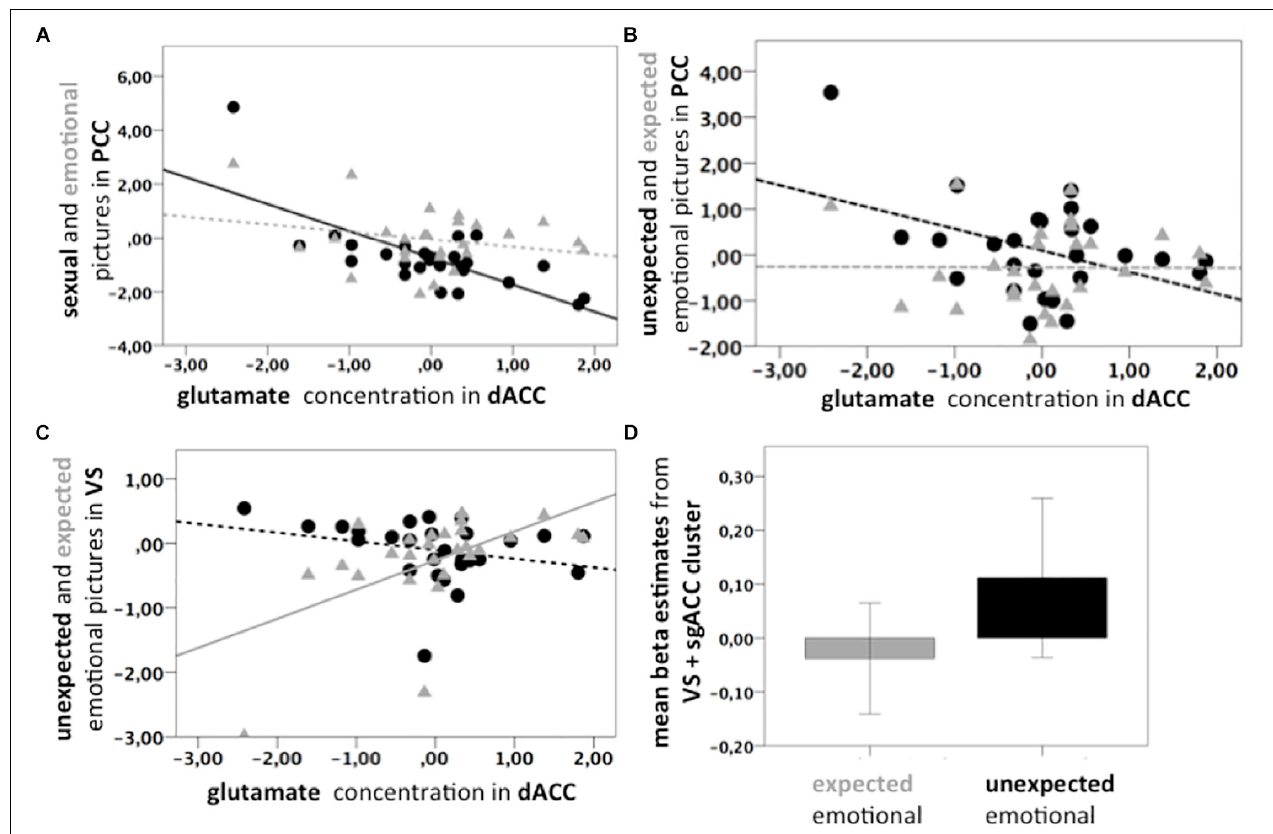
FIGURE 3 | (A) Scatter plots. Black line: Significant negative correlation of the Glu/tCr residuals in dACC and PCC BOLD response for Psex > fix ( p = 0.003, ρ = –0.556, n = 27); Gray dotted line: Non-significant correlation of Glu/tCr residuals and PCC BOLD response for Pemo > fix ( p = 0.217, ρ = 0.313, n = 27). Slopes are significantly different ( p < 0.001). Beta estimates were extracted from the correlation cluster (light blue and yellow) shown in Figure 2A . (B) Black dotted line: Non-significant negative correlation of Glu/tCr residuals in the dACC and PCC BOLD response uPemo > fix ( p = 0.462, ρ = –0.148, n = 27). Gray dotted line: Non-significant correlation of Glu/tCr residuals in the dACC and PCC BOLD response for xPemo > fix ( p = 0.980, ρ = 0.183, n = 27). Beta estimates were extracted from the correlation cluster (light green and bright green) shown in Figure 2C . (C) Gray line: Positive correlation between xPemo > fix and Glu/tCr residuals in dACC ( p = 0.004, ρ = 0.539, n = 27). Black dotted line: Non-significant negative correlation between uPemo > fix and Glu/tCr residuals in dACC ( p = 0.075, ρ = –0.348, n = 27). Beta estimates were extracted from the bright green correlation cluster shown in Figure 2D . (D) Mean beta estimates for xPemo > fix and uPemo > fix represent a relative signal increase for the unexpected condition. Data is presented in mean ± standard error mean (SEM). Beta estimates were extracted from the bright green correlation cluster shown in Figure 2D